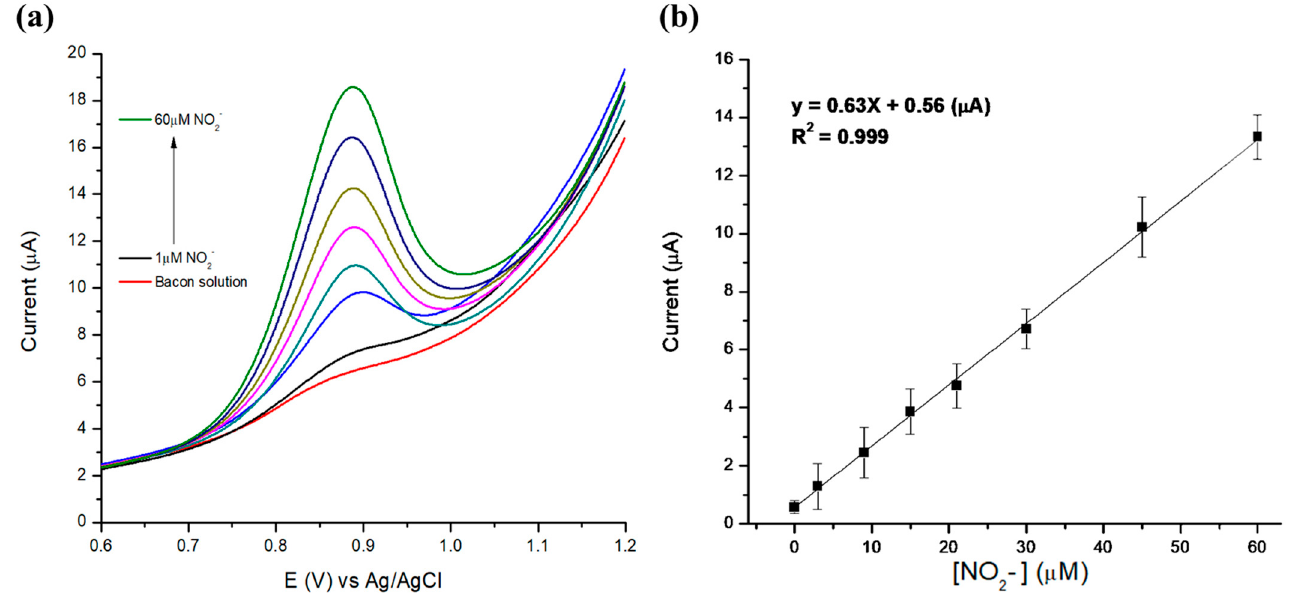
Figure 4. ( a ) CVs of the HMT-PMBI/NGNP coated electrode recorded in solutions containing nitrites extracted from bacon (red line) and after the addition of nitrites from 1 µM to 60 µM. ( b ) Plot of peak current vs. added concentration of sodium nitrite. The supporting electrolyte was 0.1 M NaCl and scan rate was 0.1 V s − 1 . Error bars were calculated from three repeat measurements.